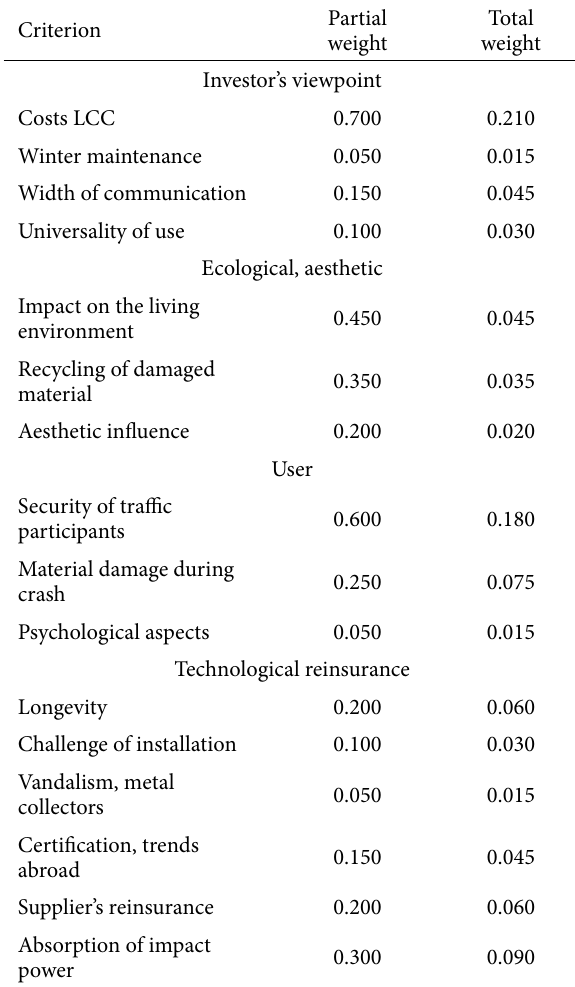
Table 3. Evaluating criteria of the 2 nd degree